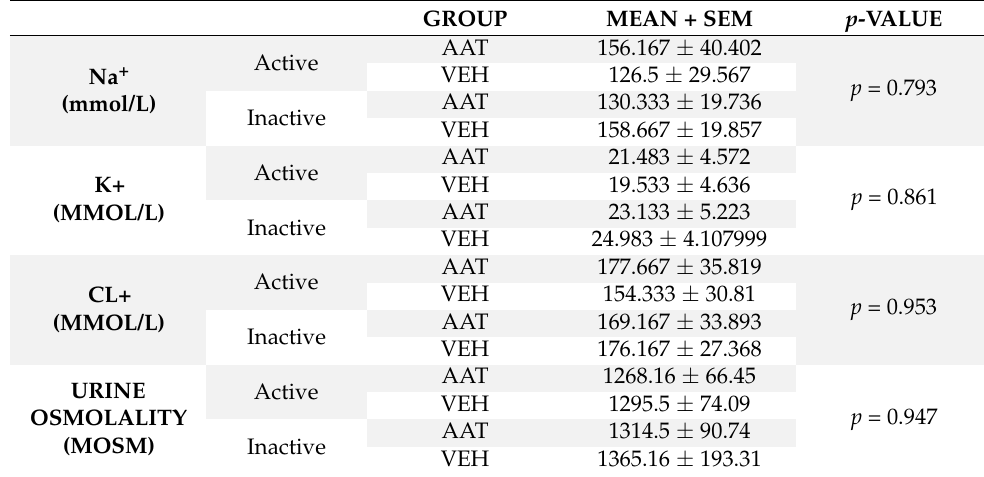
Table 1. Urine Osmolality and Urine Electrolytes were measured using the urine collected during the treatment phase. N = 6 hAAT treated (3 females and 3 males) mice and N = 6 VEH (3 females and 3 males) mice. These results were analyzed using a One-Way ANOVA followed by a Holm–Sidak